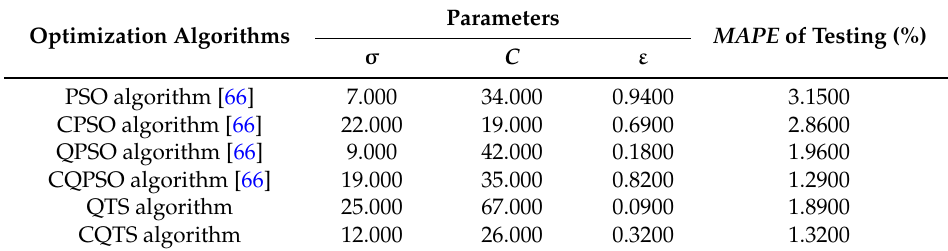
Table 7. Parameters determination of SVRCQTS, SVRQTS, and other models (Example